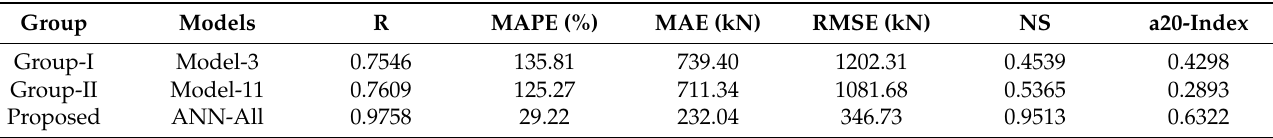
Table 7. Overall results of analytical and ANN model.